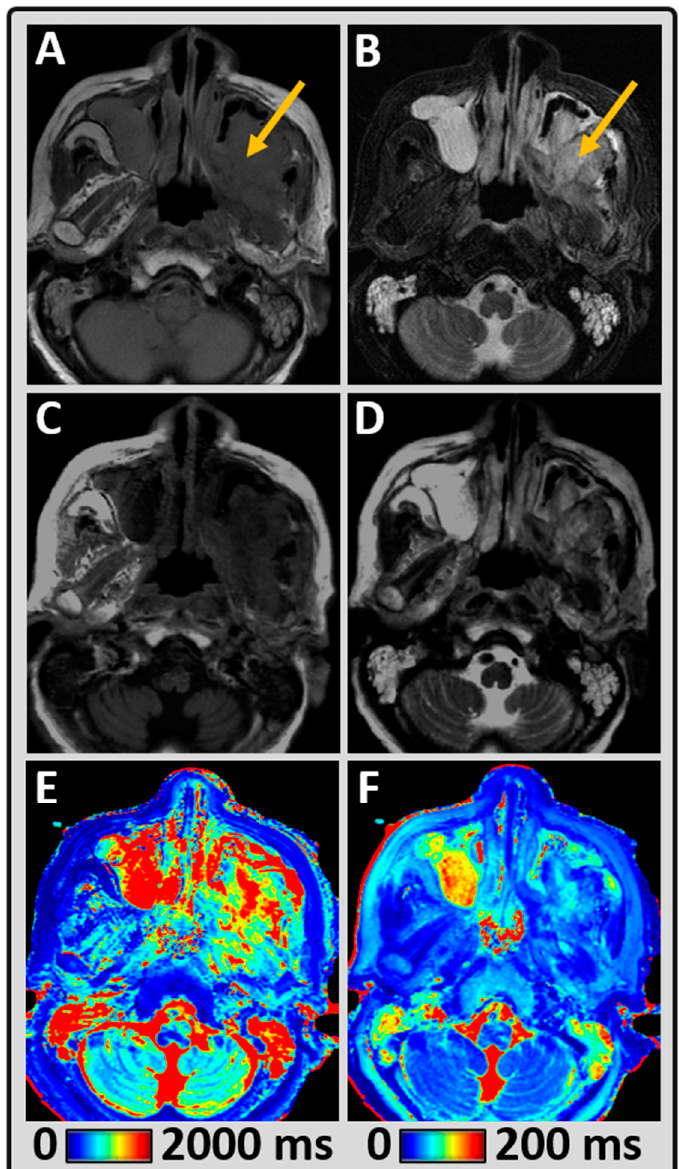
Figure 3. Representative MRI data from an 83-year-old female patient with yellow arrow pointing at left maxillary sinus secretory carcinoma of the salivary gland treated with radiation therapy. ( A,B ) Conventional qualitative T1w and T2w images demonstrating the tumor lesion; ( C,D ) Synthetically generated T1w and T2w images using MAGiC; ( E , F ) MAGiC-generated quantitative T1 and T2 maps.